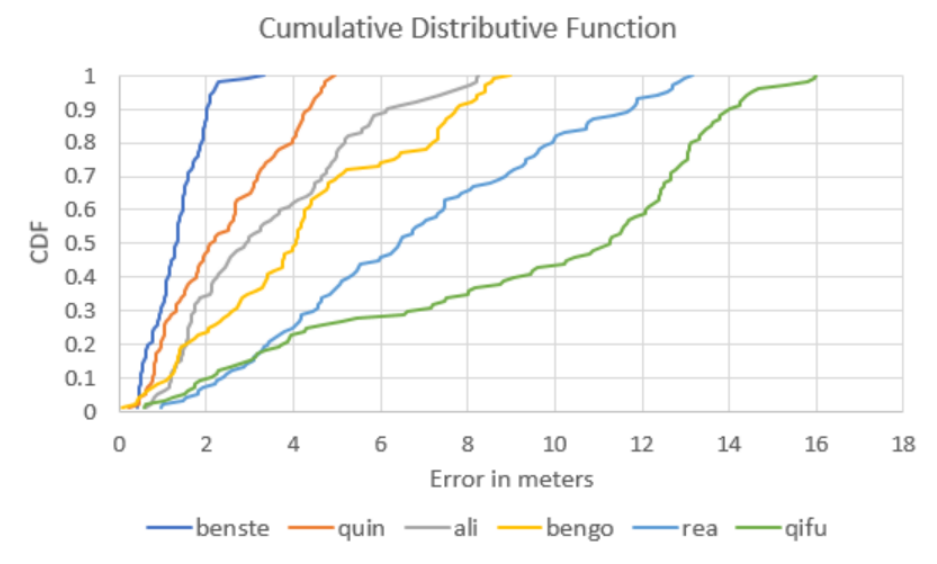
Figure 17. Cumulative Distributive Function: of the 2 D error in meters as tested in Microsoft Indoor Positioning competition 2018. The STEPS (benste) reached an average accuracy of 1.3